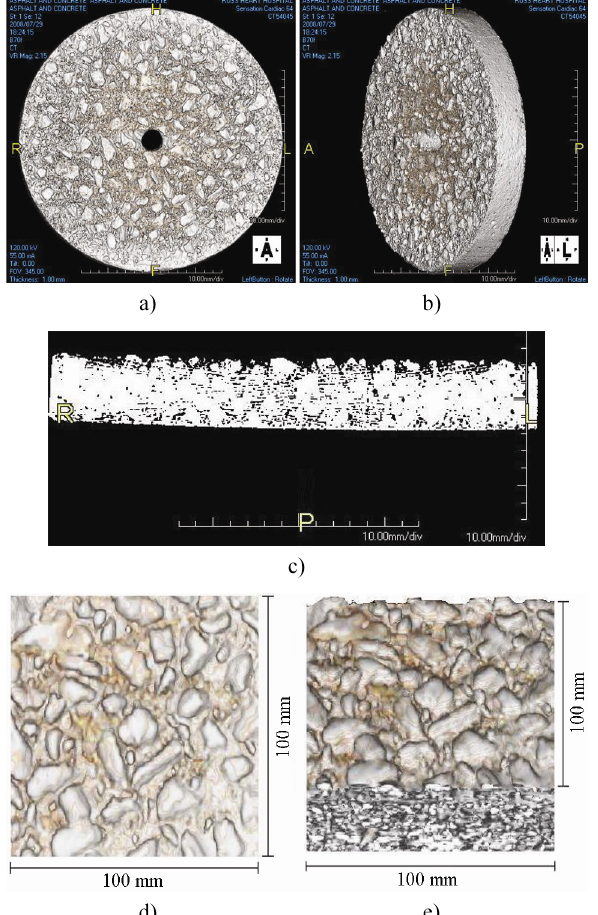
Fig. 3. Exposed aggregate concrete sample CT scan rendering: a) top view; b) side view; c) two-dimensional CT scan slice; d) top view; and e) side view of 100 mm square